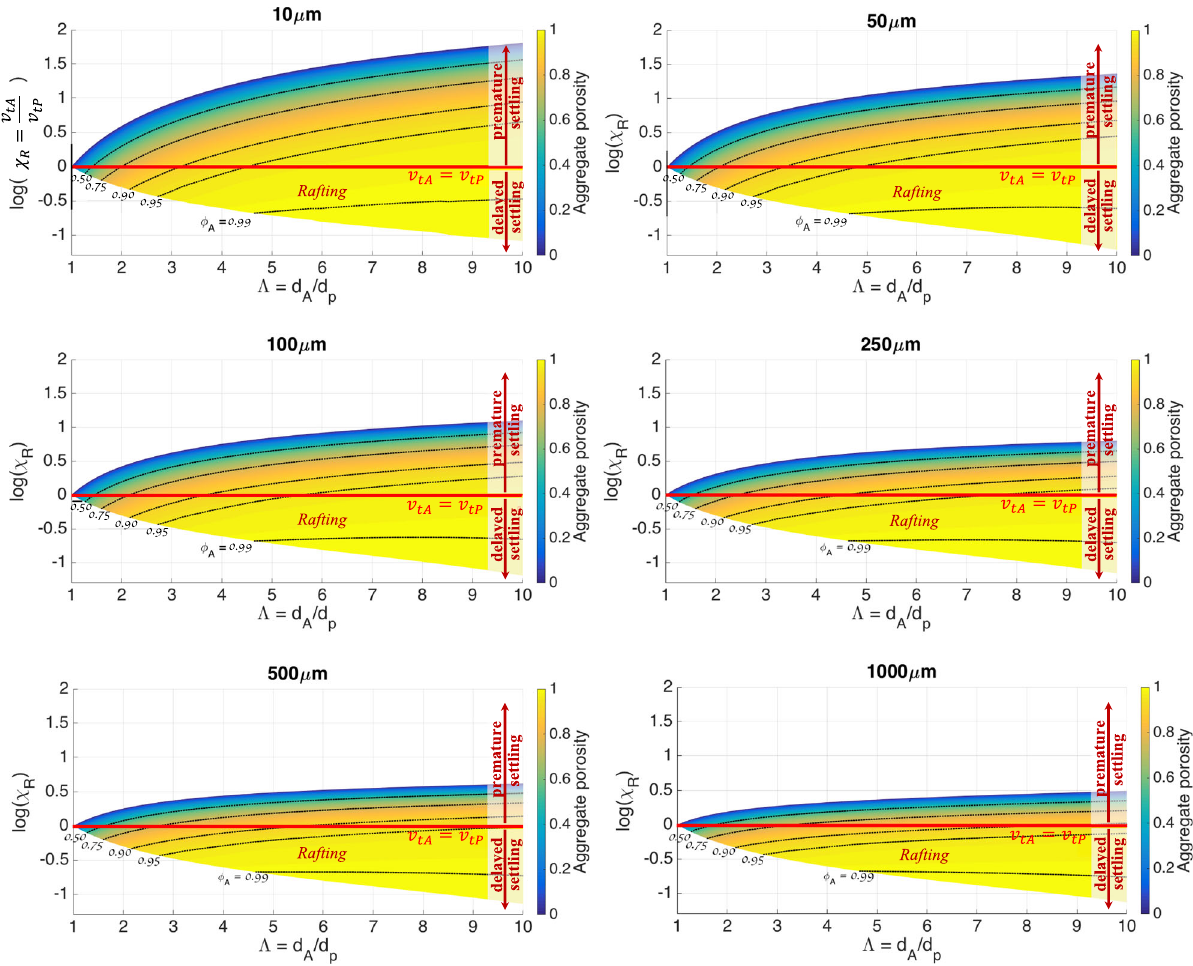
Fig. 2 The sedimentation charts. Premature and delayed sedimentation expressed by the rafting factor ( χ R ) as a function of the aggregate-to-core diameter ratio ( Λ ) and of the aggregate porosity ( ϕ A ) for six different core sizes (10 μ m, 50 μ m, 100 μ m, 250 μ m, 500 μ m, 1000 μ m). The red line v tA = v tP indicates the separation between premature (log( χ R ) > 0) and delayed (log( χ R ) < 0)